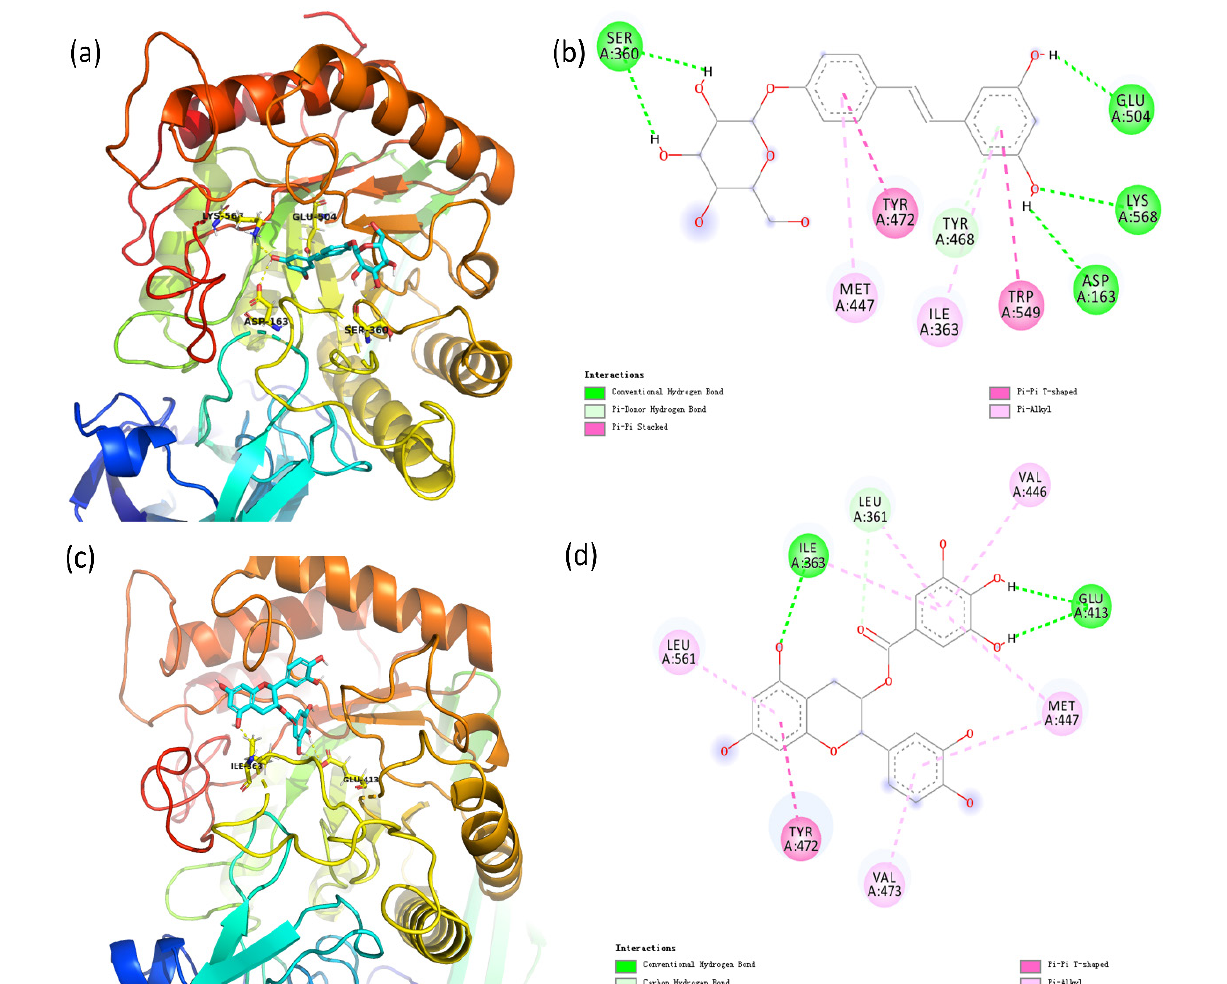
FIGURE 5 - A stereo view of the docking conformation of HZ-1 (a) and HZ-2 (c) (stick model) in the active site of EcGUS. The carbon atoms in these two molecules ( HZ-1 and HZ-2 ) were colored in cyan. Residues in EcGUS interacting with HZ-1 (b) and HZ-2 (d) are shown (conventional hydrogen bond, green; π-donor hydrogen bond, light green; π-π stacked,